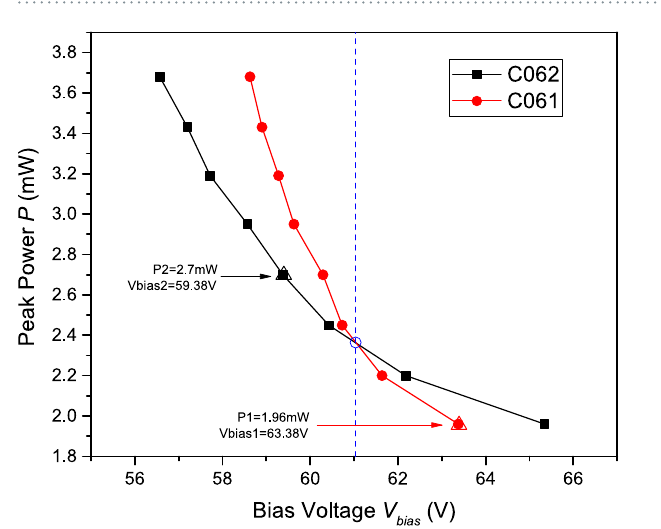
Figure 3. Click thresholds versus biased voltage of the APDs in two different SPDs C062 and C061. Here, for a particular biased voltage of APD Vbias, each point in the red (black) curves represents the minimum value of the peak power of SPD C061 (C062). The blue circle is the cross point of the two curves. The triangles are two different combinations in the feasibility